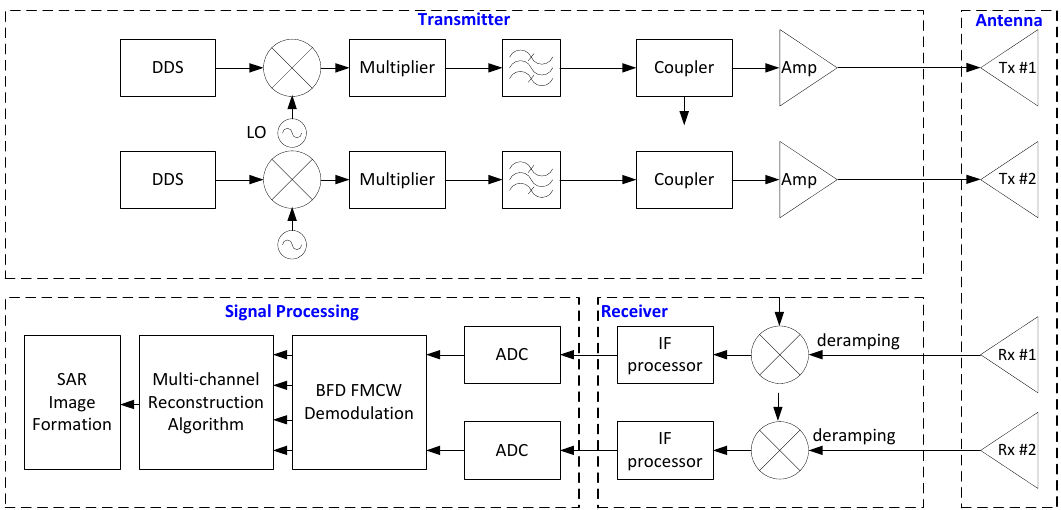
Figure 10. System block diagram for MIMO video SAR with beat frequency division FMCW waveform in the case of two Tx channels and two Rx channels ( M = 2, N = 2). DDS: direct digital synthesis;